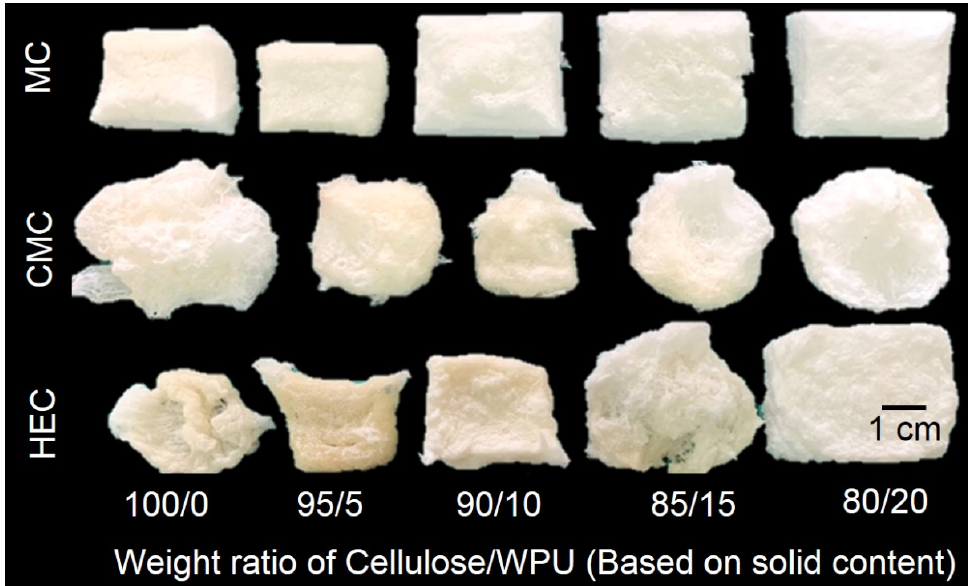
Figure 3. The appearance of cellulose/WPU composite aerogels.